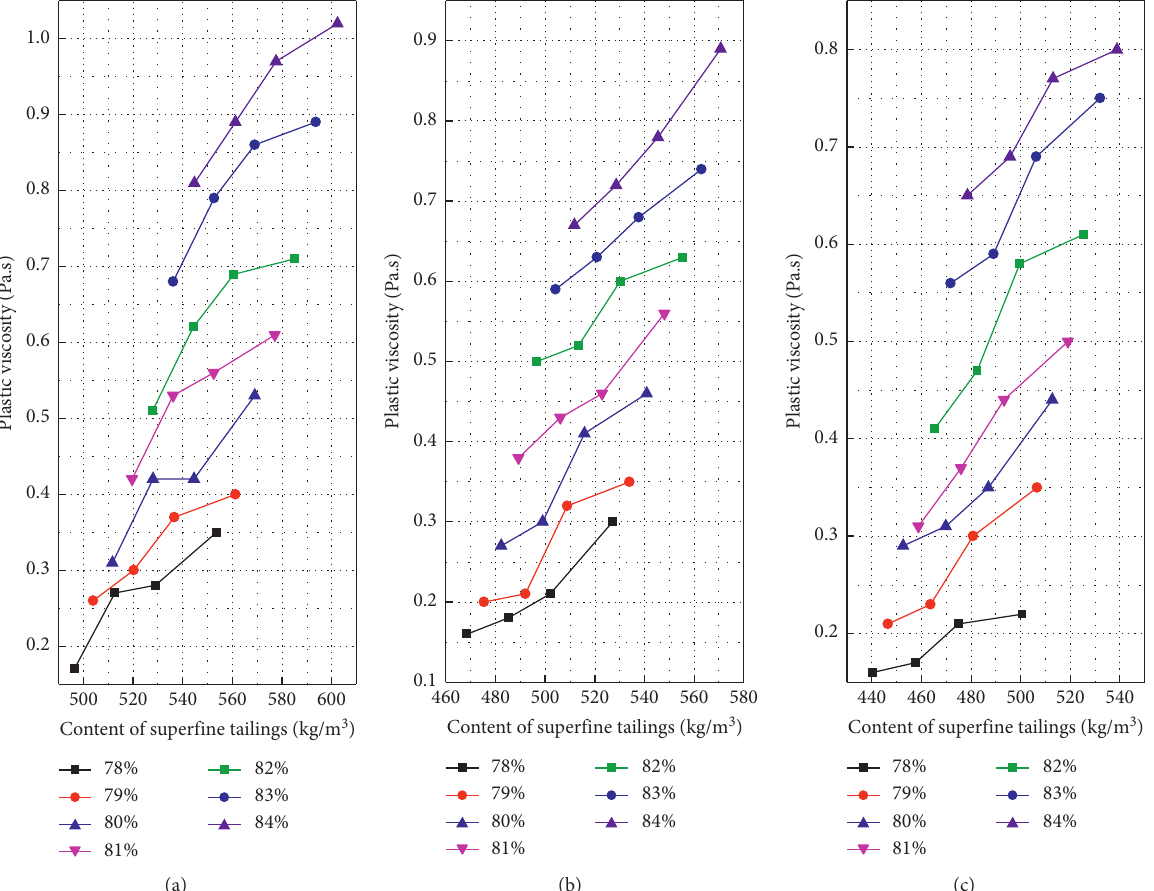
Figure 9: Relationship between ultrafine particle content and plastic viscosity at different gradations. (a) Waste rock: desert sand � 5 :5. (b) Waste rock: desert sand � 6:4. (c) Waste rock :desert sand � 7: 3.